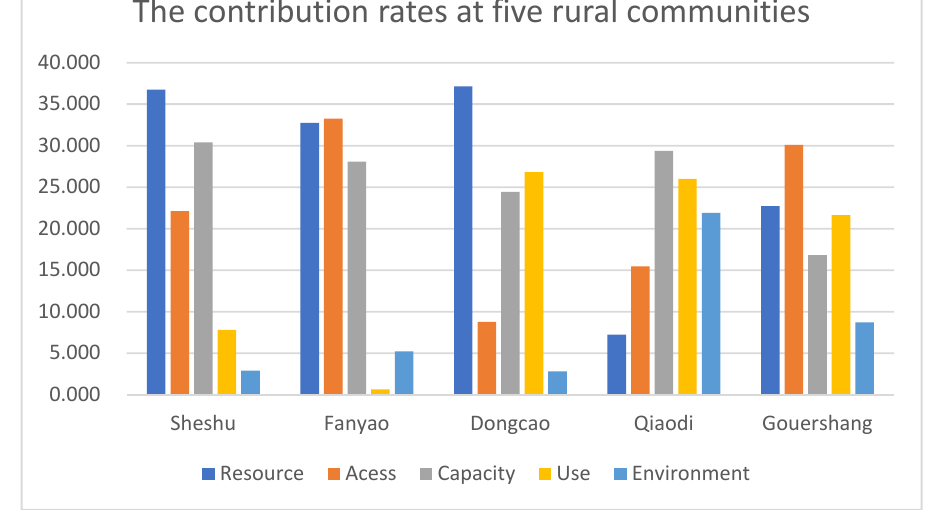
Figure 3. The contribution rates at five rural communities.